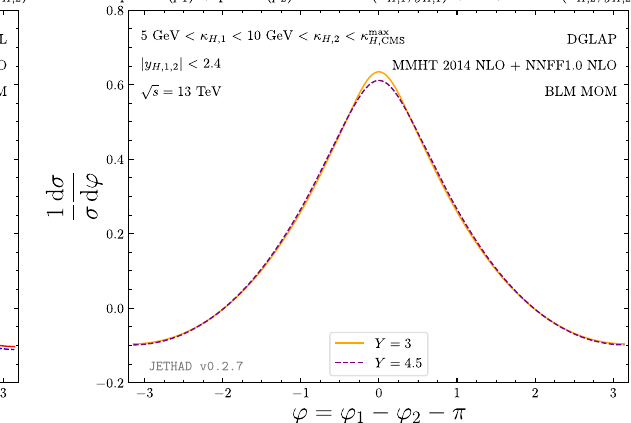
√ s = 13. Results are given in the asymmetric CMS interval, Y , and